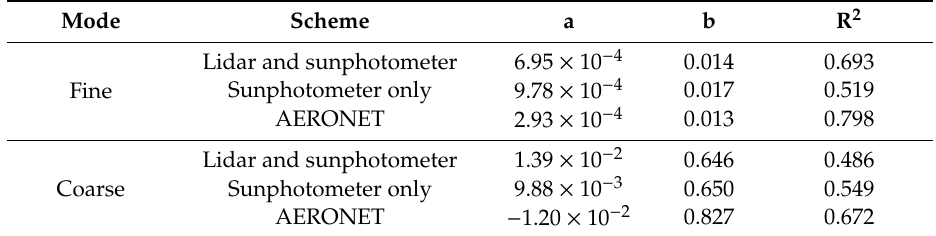
Table 3. Linear fit parameters and R-squared values for volume area vs. AOD @ 440 nm corresponding to the fine and coarse modes of the di ff erent